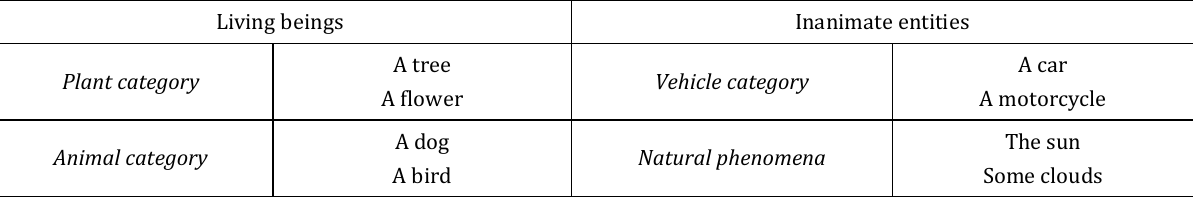
Vehicle category Natural phenomena